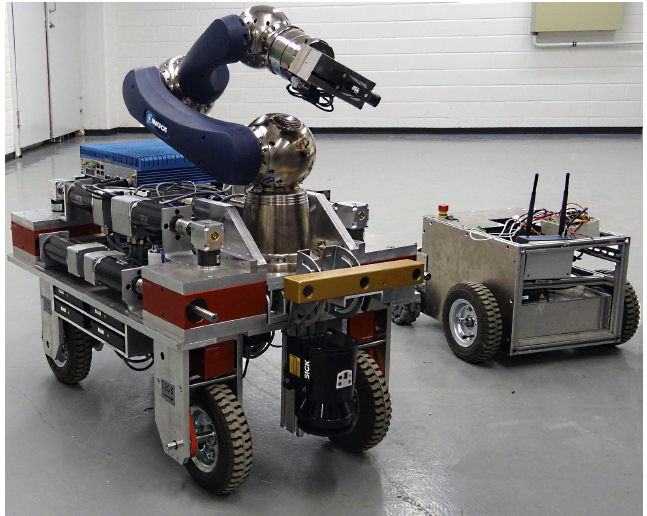
Figure 7. Experimental setups : iMoro ( left ): a four-wheel independently steering WMR ( δ = ( 1,2 ) ), and LabRat ( right ): a differential drive WMR ( δ = ( 2,0 ) ) with active fixed wheels at the